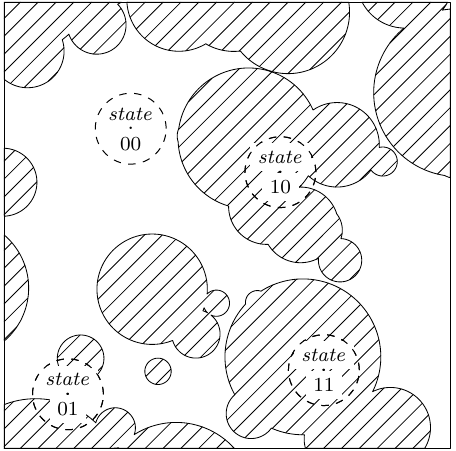
Figure 3: Examples of each disc state in disc-state conta- gion. Hatched regions denote locations inside the realisa- tion of X .